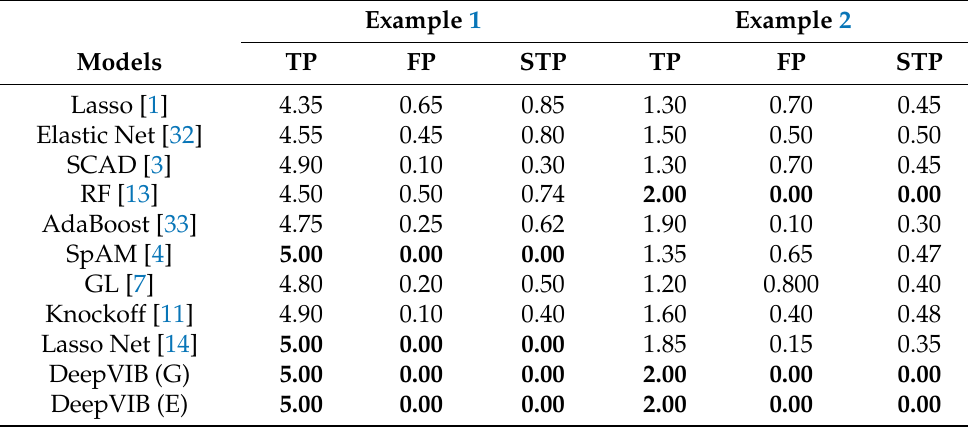
Table 2. The averaged performance of variable selection (Examples 1 and 2).